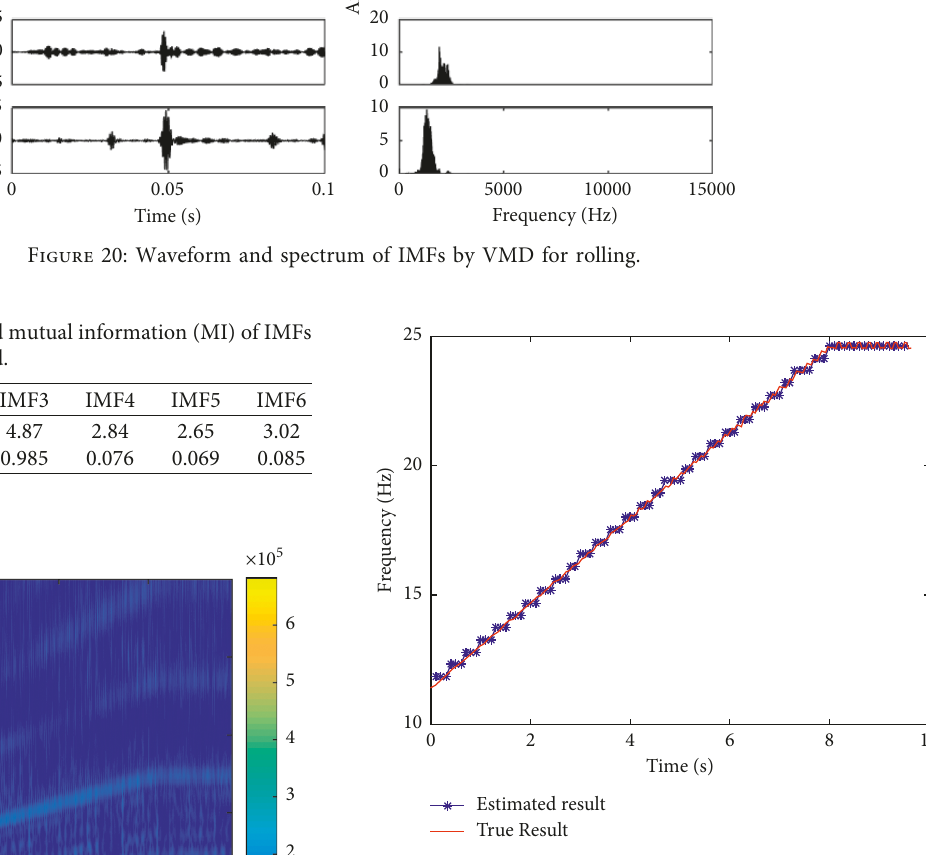
Figure 22: Comparison between estimated instantaneous rota- tional frequency and true result of rolling bearing vibration signal with rising